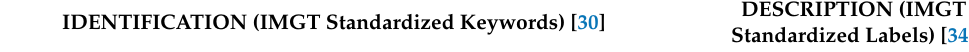
Table 6. The ten most classical IG and TR entity types and associated prototypes. Entity types are identified with IMGT standardized keywords [30] (IDENTIFICATION axiom [30,31]). Prototypes are described with IMGT standardized labels [34] (DESCRIPTION axiom